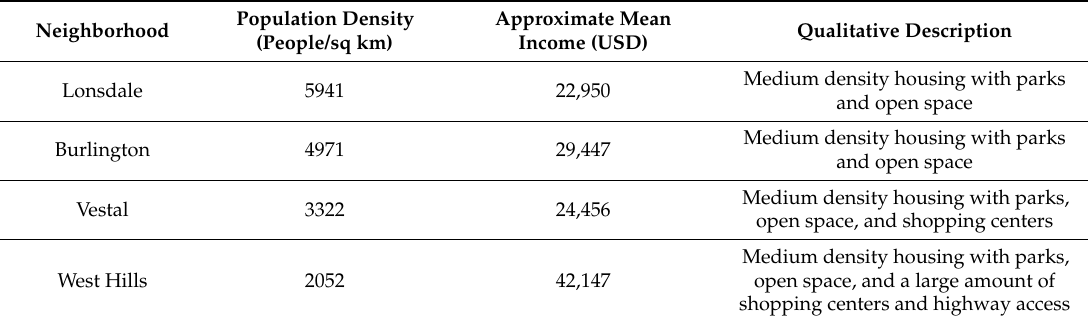
Table 1. Population density, approximate mean income, and general qualitative description of four Knoxville, Tennessee neighborhoods examined in this study [64].